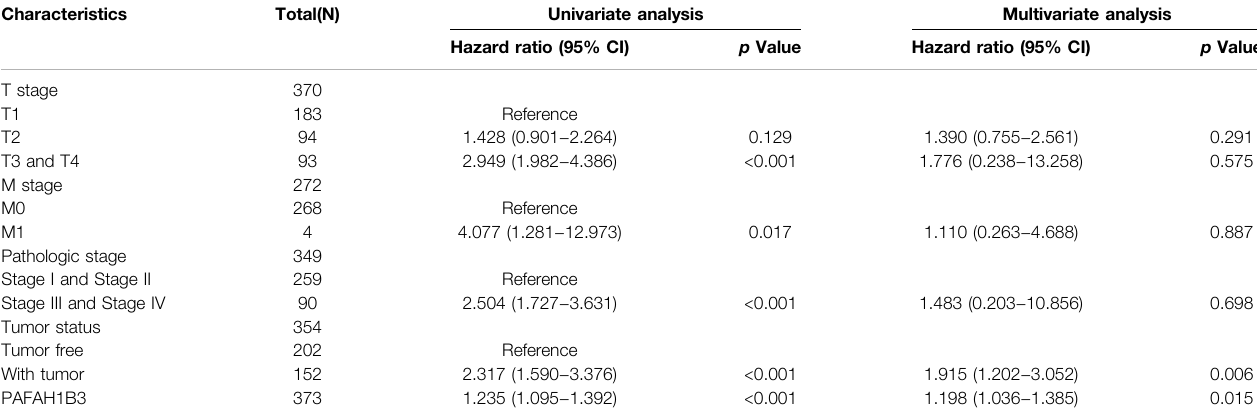
TABLE 2 | Univariate and multivariate Cox regression analyses of clinical characteristics associated with OS of LIHC.